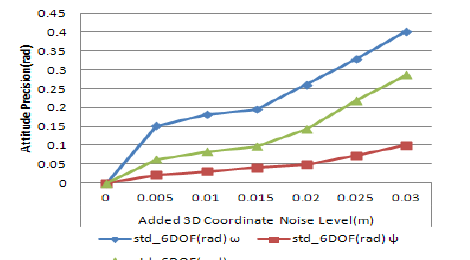
Figure 13. Variation of position precision at different noise level of 3D